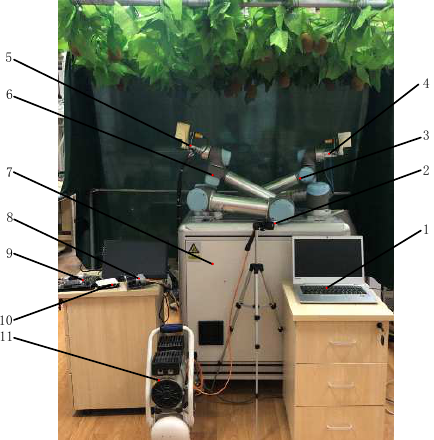
Figure 21. Double-arm harvesting robot test platform: 1—host end; 2—depth camera; 3—right robotic arm; 4—end-effector one; 5—end-effector two; 6—left robotic arm; 7—dual-arm collaboration platform; 8—jetson nano; 9—jetson Tx2; 10—switch; 11—air compressor.